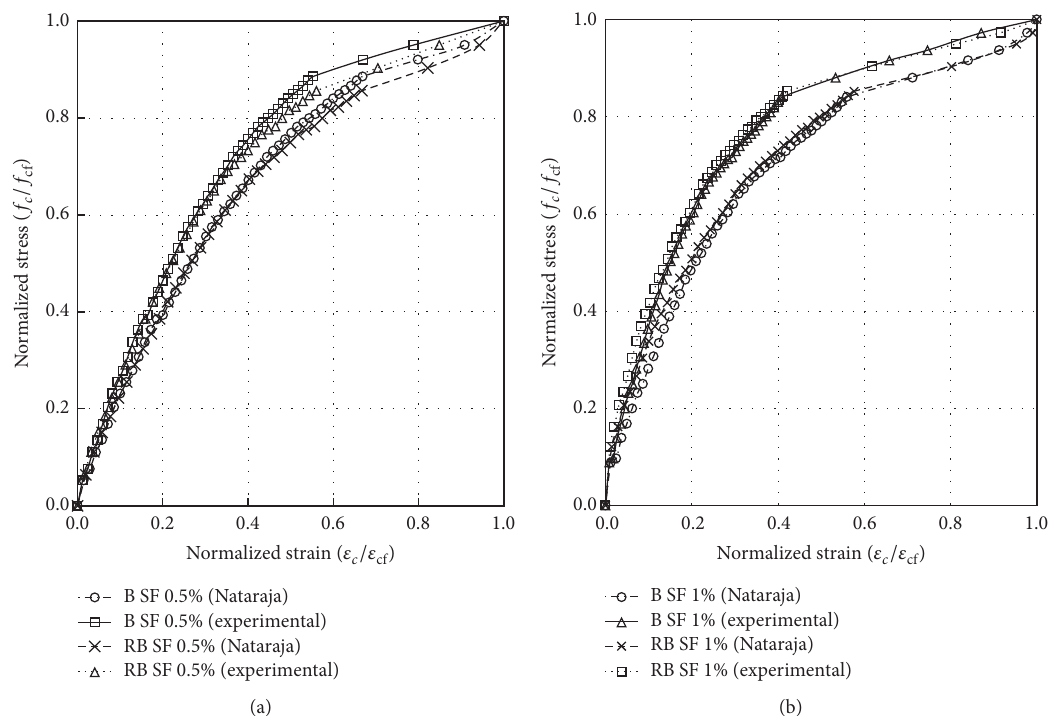
Figure 17: Normalized stress-strain diagram at 28 day; (a) 0.5% SF and (b) 1%